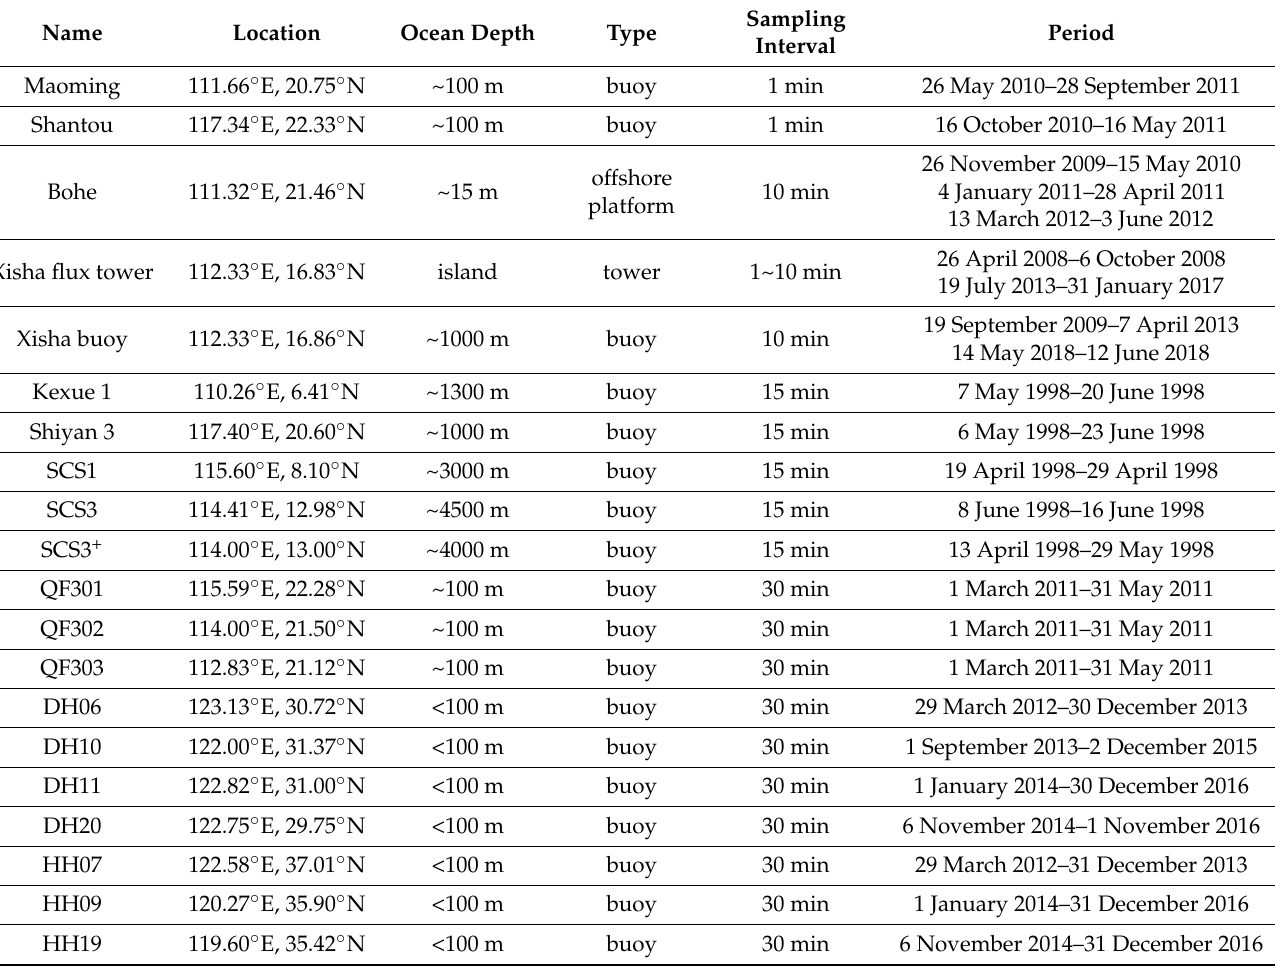
Table 1. Information on in situ observations collected in this study. The station names with prefixes “DH” and “HH” are located in the ECS and the YS, respectively. The remaining 13 stations are located in the SCS. The data span from 1998 to 2018 and the sampling intervals vary from 1 min to 30